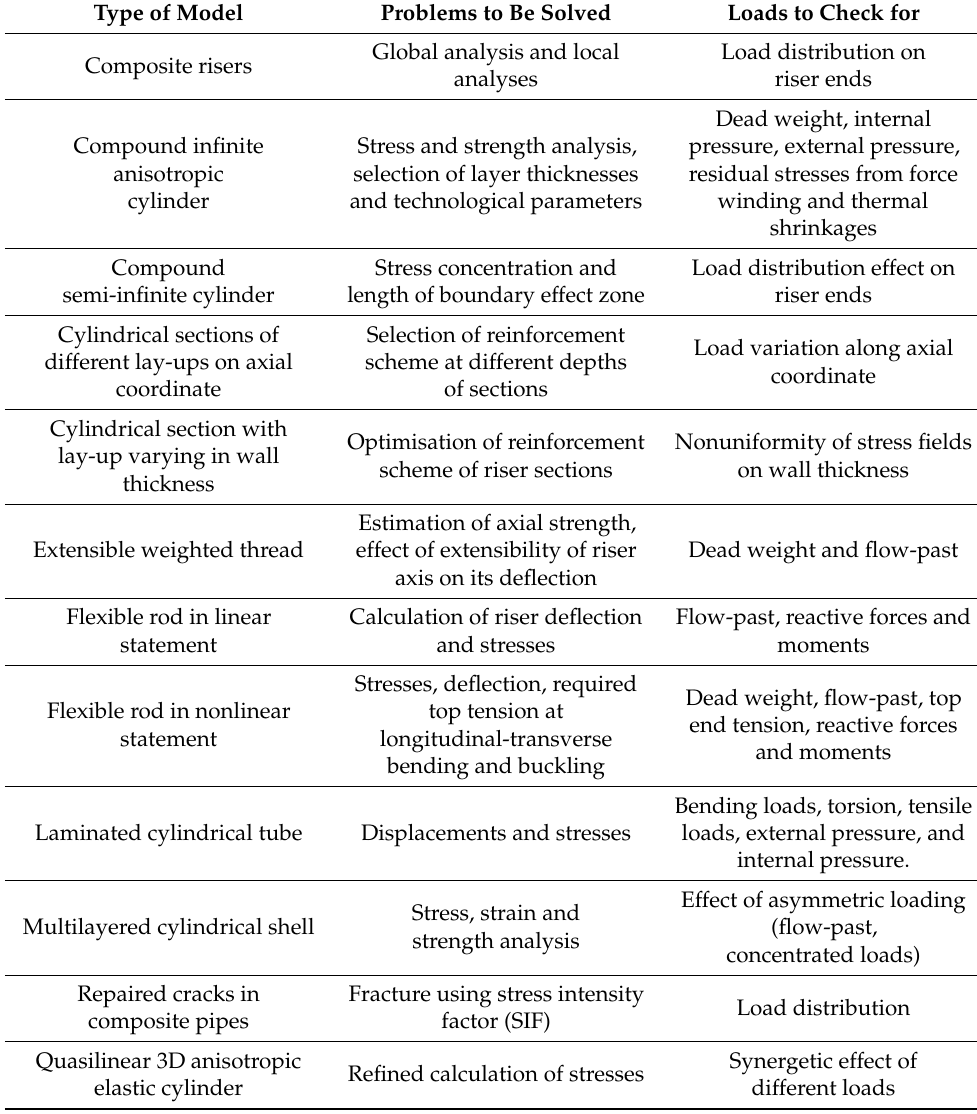
Table 3. Models for analysis of mechanical behaviour of composite